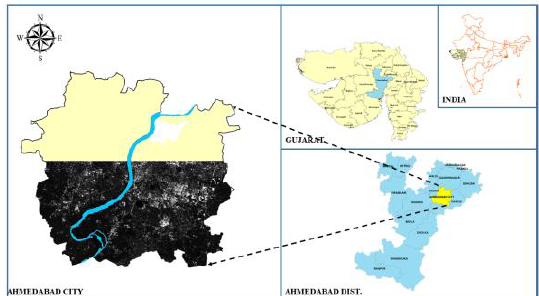
Figure 1. Location map of the study area and Radarsat-2 HH